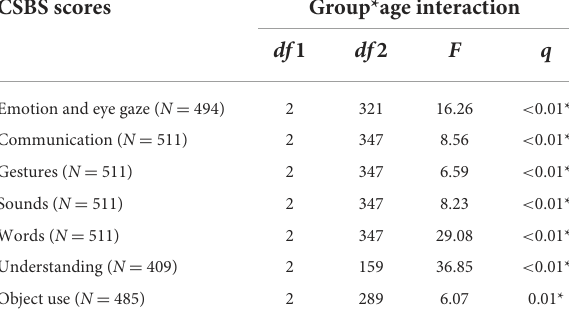
TABLE 3 Longitudinal mixed linear model with group by age interaction